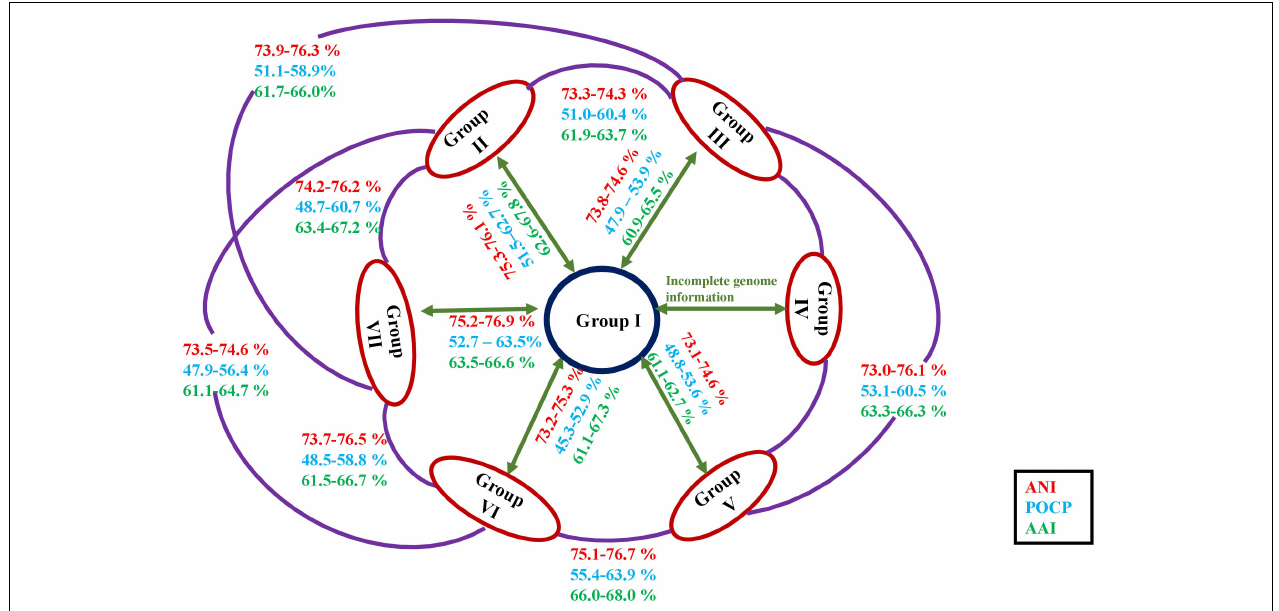
FIGURE 4 | Diagrammatic representation of the ANI, AAI, and POCP values in between the members of each group of the genus Roseomonas